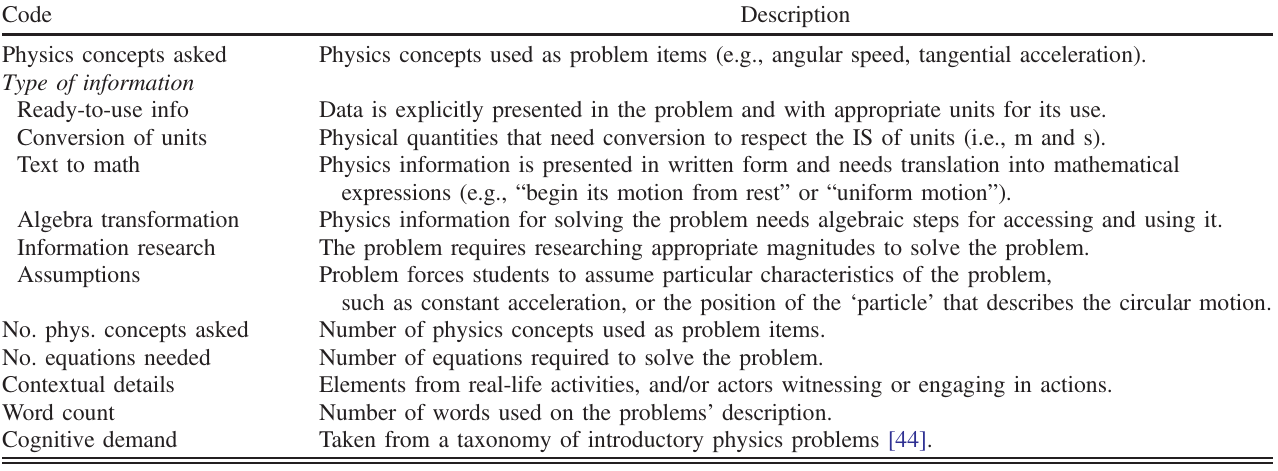
TABLE I. Code description of problem characteristics for problem elaboration.